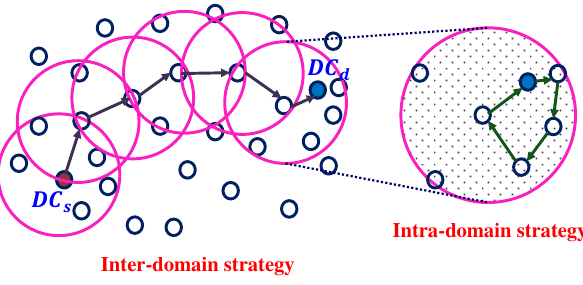
Figure 5. Inter- and intra-domain schemes between the distribution centers